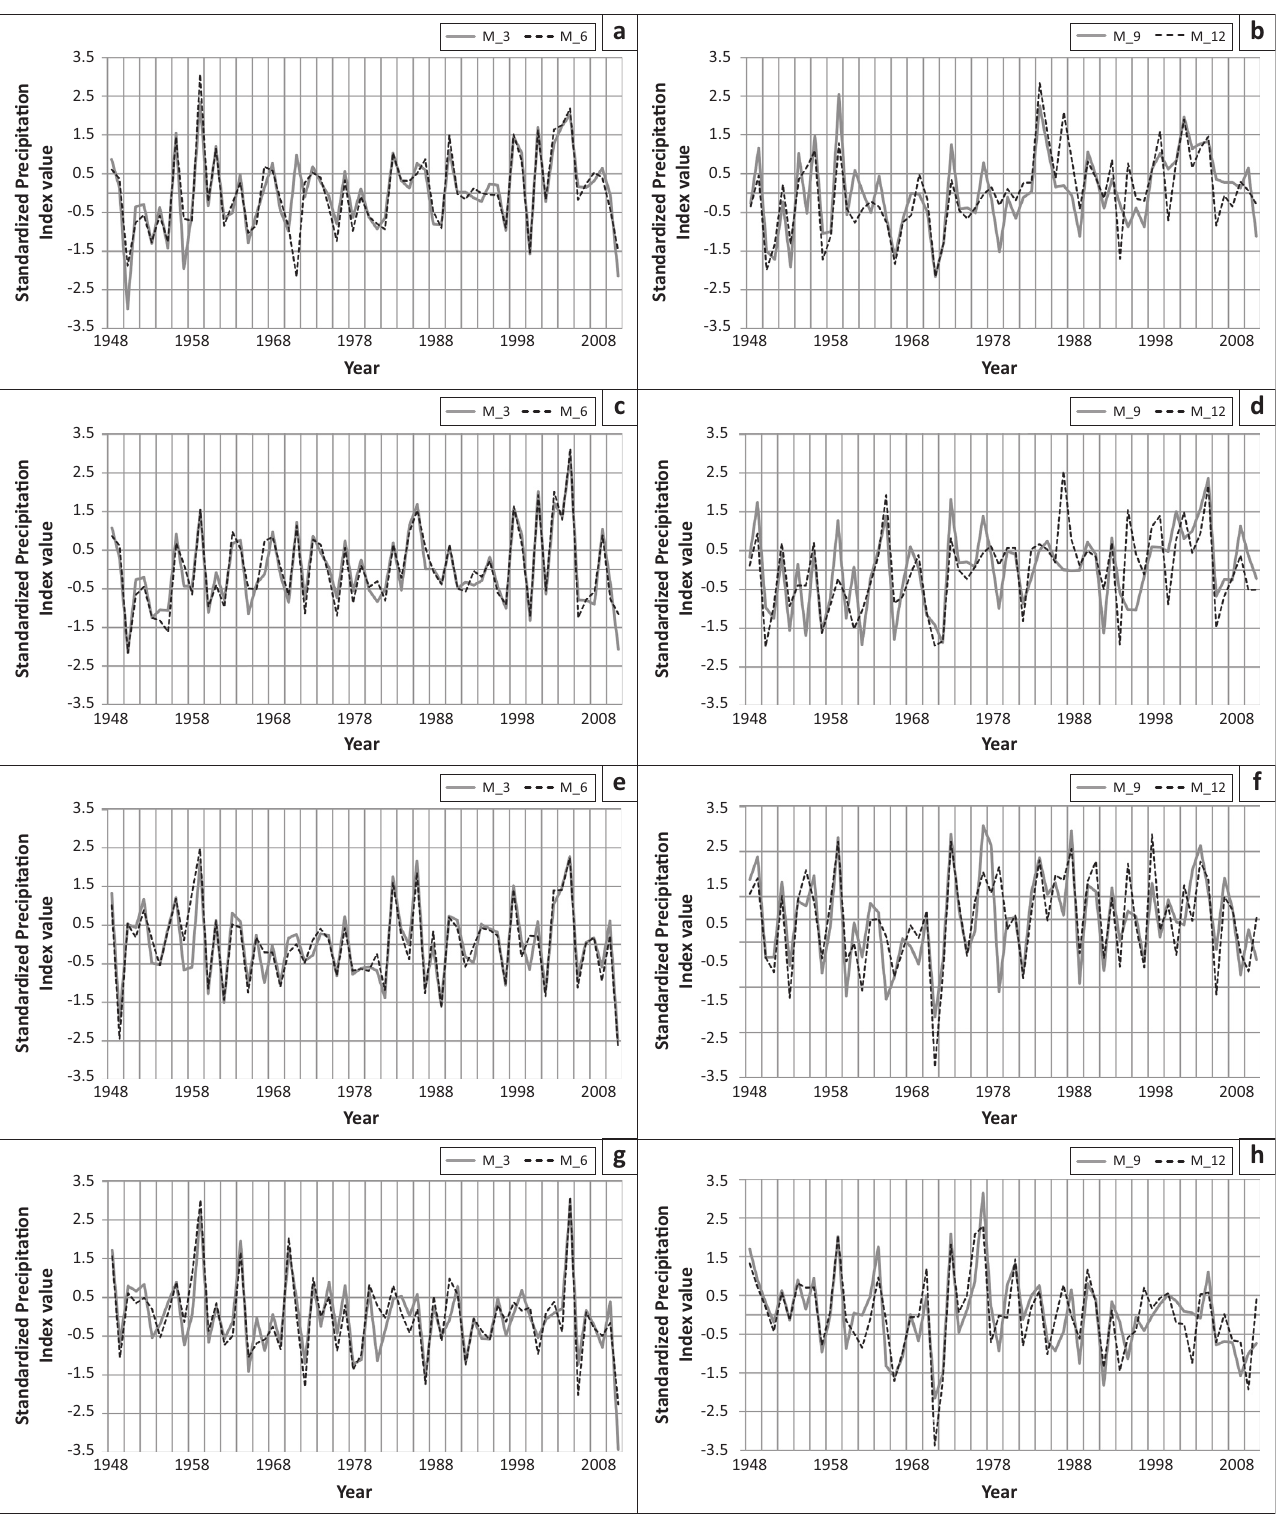
FIGURE 2: Drought in (a) Rangpur, (c) Dinajpur, (e) Bogra, (g) Ishurdhi and (i) Rajshahi based on 3-month SPI (M_3) and 6-month SPI (M_6). Drought in (b) Rangpur, (d) Dinajpur, (f) Bogra, (h) Ishurdhi and (j) Rajshahi based on 9-month SPI (M_9) and 12-month (annual) SPI (M_12).